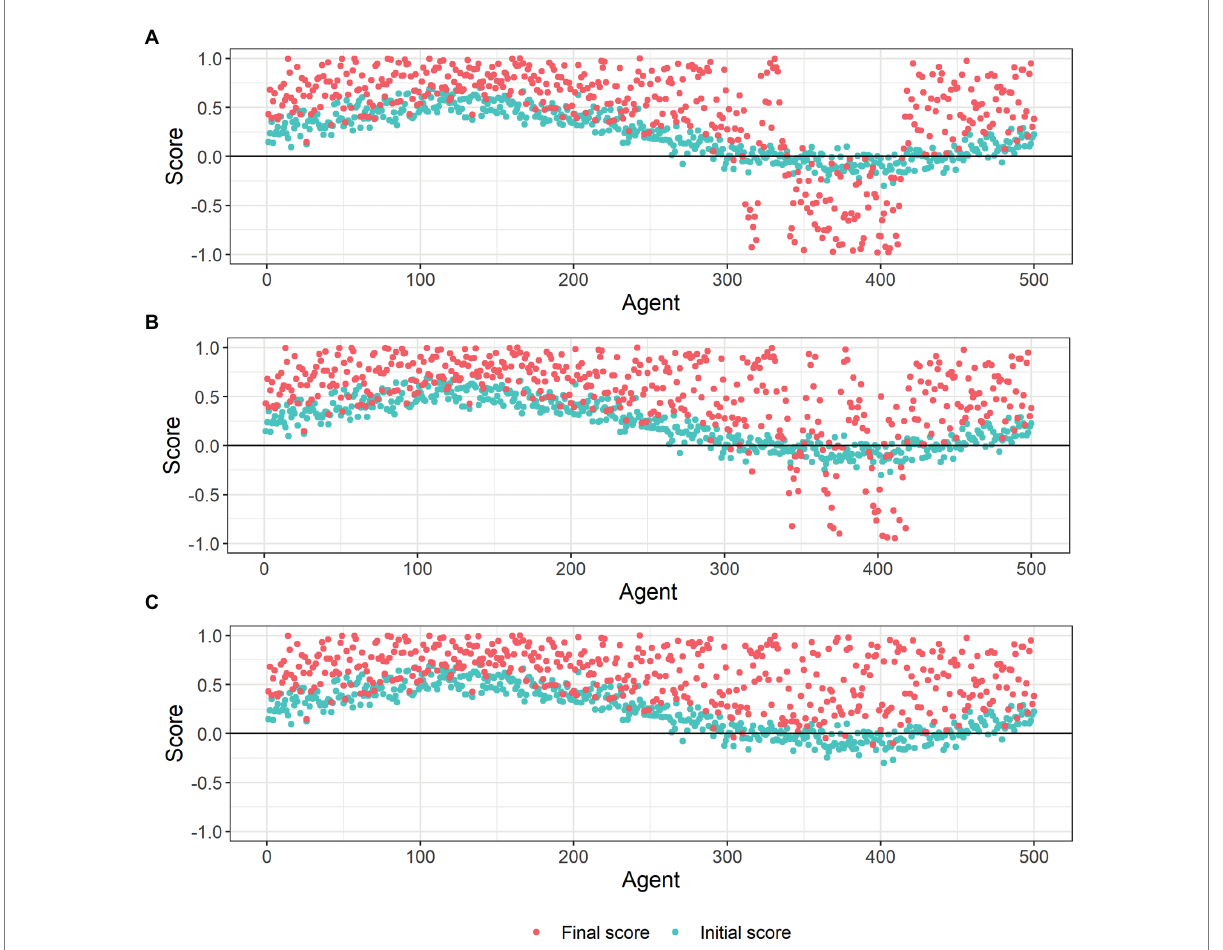
FIGURE 5 Agents’ initial and final scores in small-world networks with different rewiring probabilities: 0.1 (A) , 0.2 (B) and 0.3 (C)